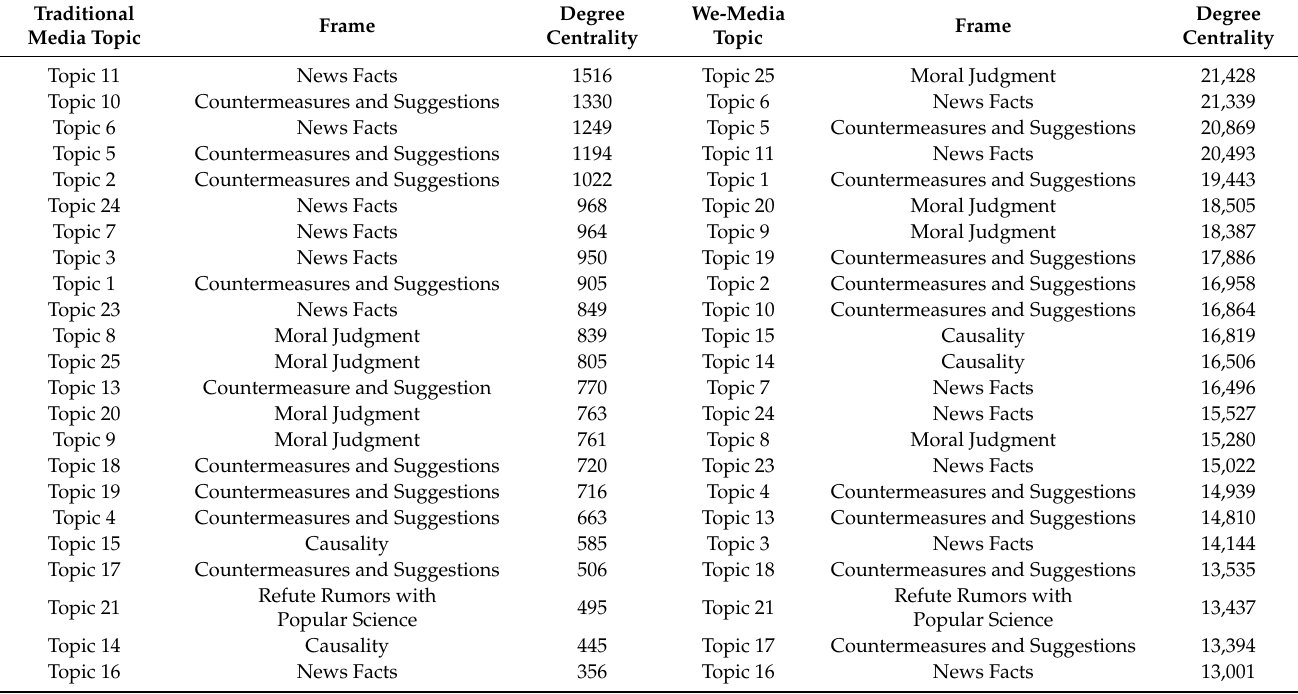
Table 7. Degree Centrality of Agenda